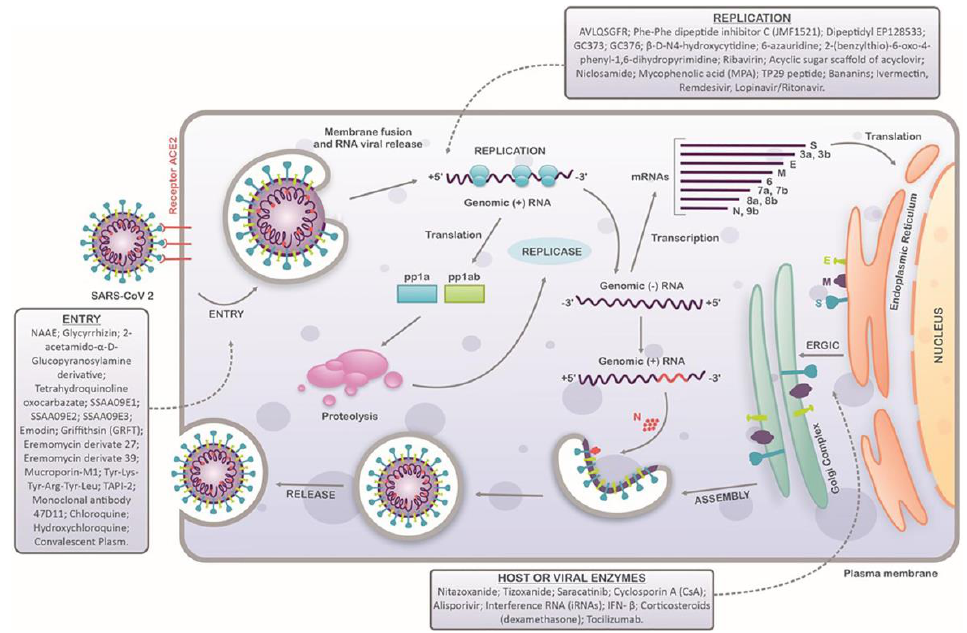
Figure 2. Schematic representation of SARS-CoV-2 replication cycle in host cells. SARS-CoV-2 at- taches to the host cells by interacting with the ACE2 receptors and spike proteins. After entry, the viral uncoating process releases the viral genome, and the replication stage occurs (translation and transcription). Structural proteins are produced in the intermediate compartment of the endoplasmic reticulum with the Golgi complex and forwarded to assembly, packaging, and virus release. Com- pounds with antiviral activity against SARS-CoV-2 are indicated in each step of the virus replication cycle. Adapted with permission from ref. [32], published by Frontiers,